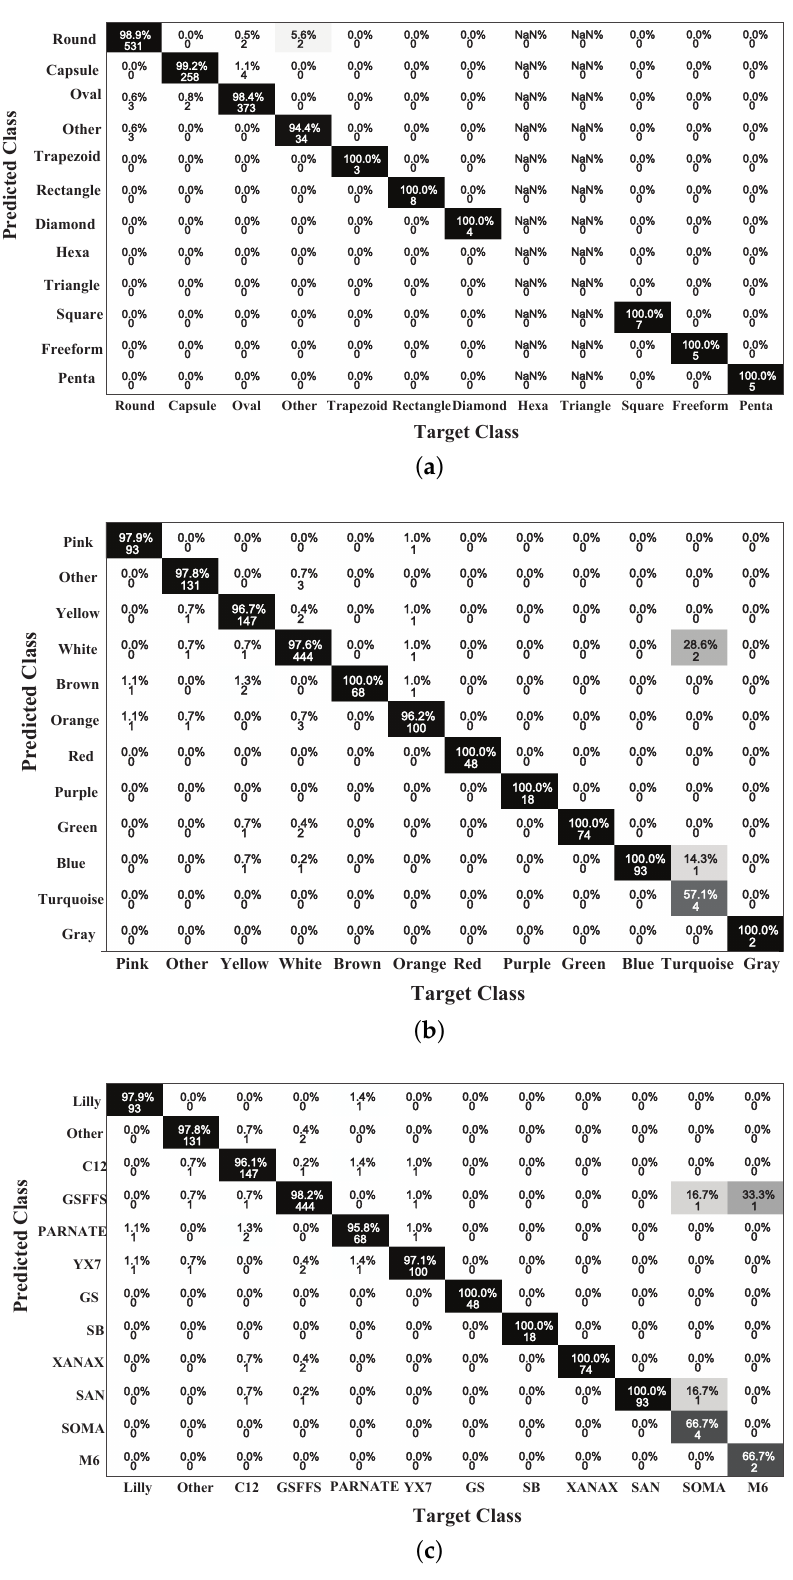
Figure 10. Confusion matrices reporting our model accuracies w.r.t. predicting pill: ( a ) shape, ( b ) colors, and ( c )